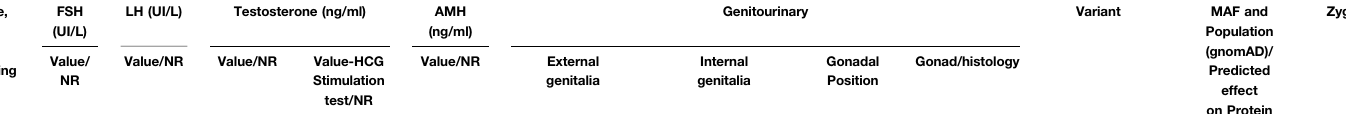
TABLE 2 | ( Continued ) Clinical phenotype, hormonal pro fi le and details of variants identi fi ed in 12 individuals with disorders of gonadal